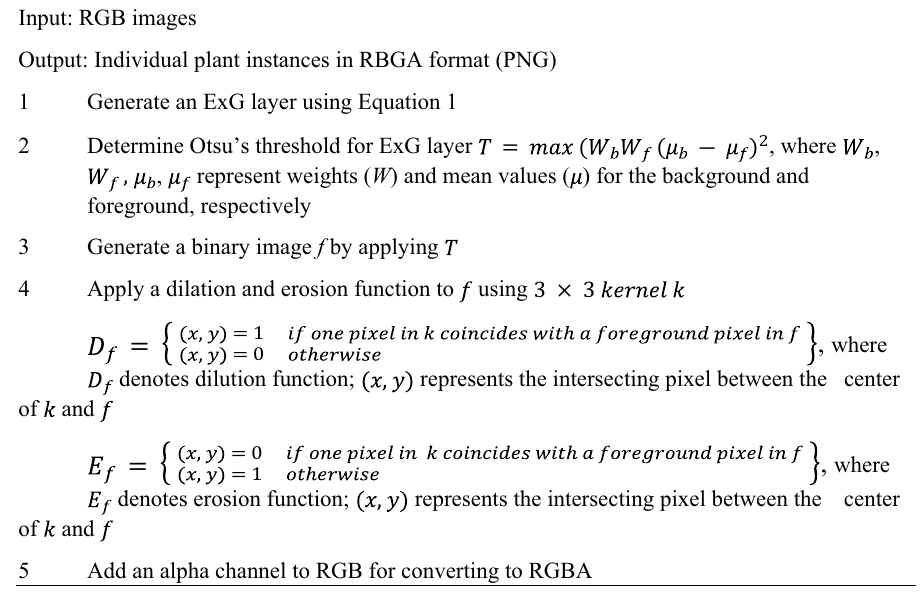
Algorithm 2: Automated plant clip